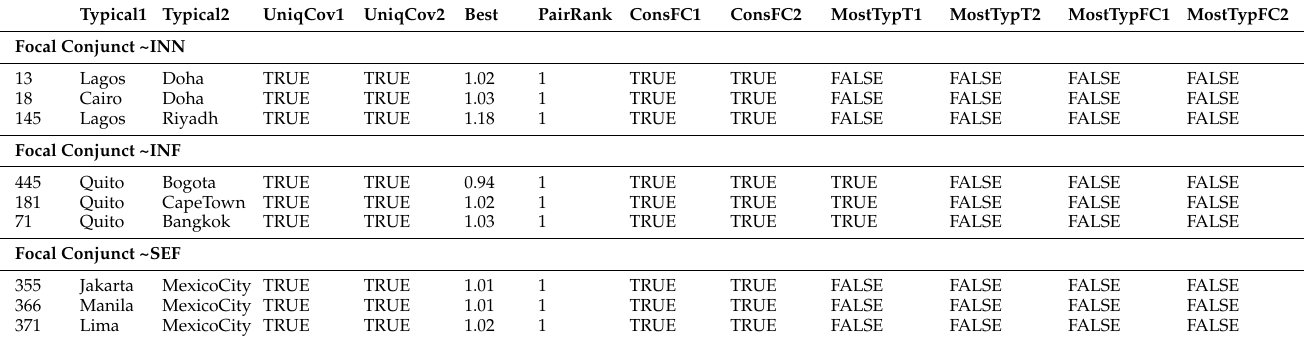
Table 11. Comparative analysis of two typical cases for ~OVE.